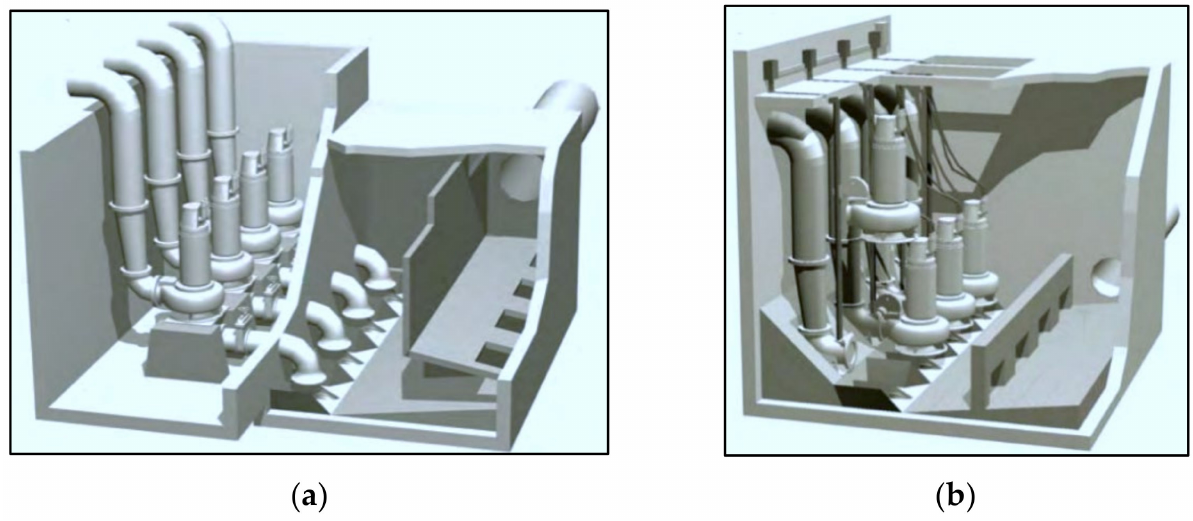
Figure 1. ( a ) High level entry intake structure; ( b ) low level entry intake structure [22]. Reprinted and adapted with permission from Ref. [22]. 2012, Hydraulic Institute Standards